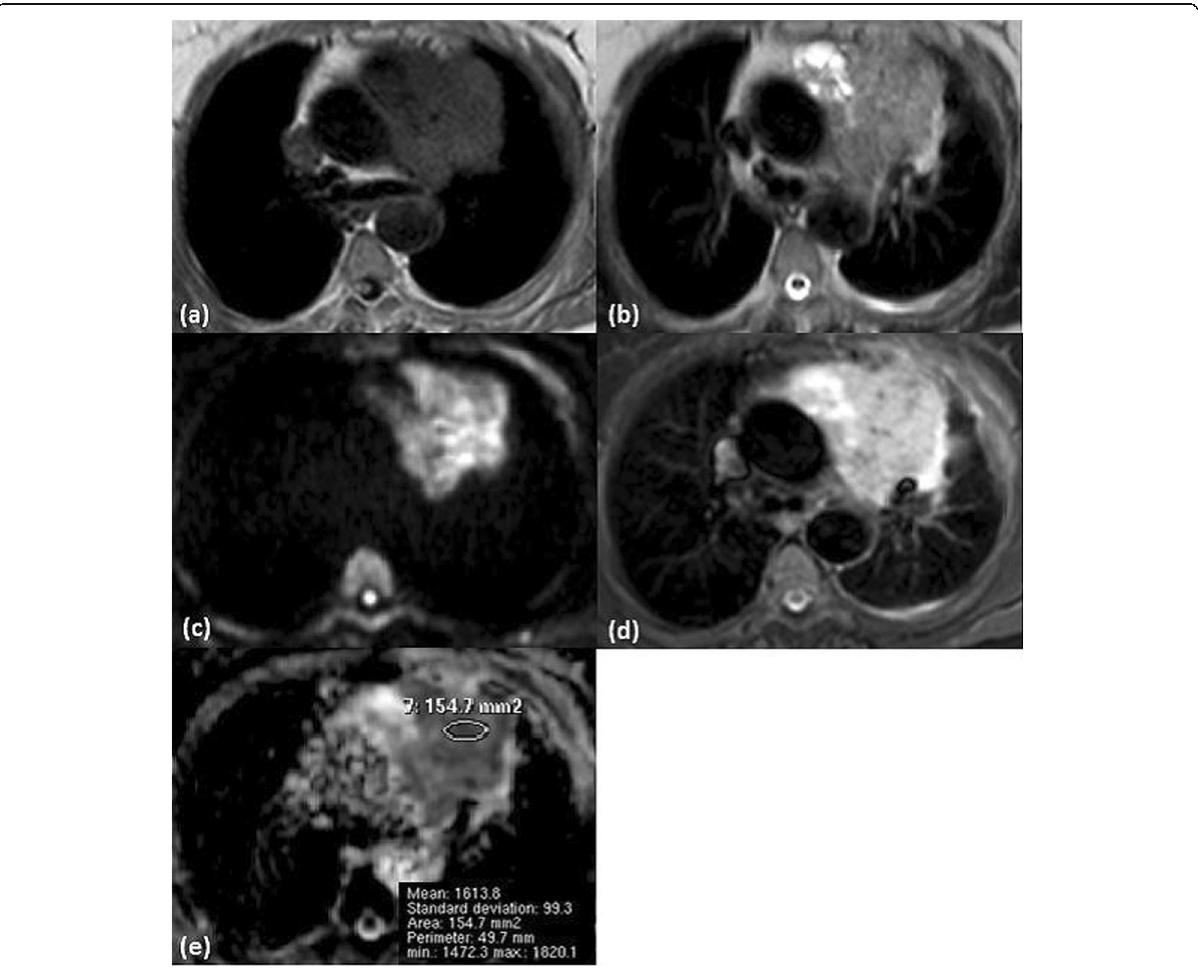
Fig. 8 Squamous cell carcinoma of lung origin (bronchogenic carcinoma: NSCLC): A 62-year-old female clinically presenting with cough, dyspnea and chest pain underwent MDCT of the chest that revealed an anterior mediastinal mass. a Axial T1 WI, b axial T2 WI and d axial STIR WI show a well-defined rather ovoid-shaped anterior mediastinal mass displaying intermediate T1 and relatively bright T2 and STIR signal intensities. Small areas of breaking down exhibiting low T1 and bright T2 and STIR signal intensities are noted. The lesion (sparing the small areas of breaking down) shows restricted diffusion by being bright on c DWI and dark on the e ADC map. ADC mean = 1.63 × 10 − 3 mm 2 /s and ADC min = 1.47 × 10 − 3 mm 2